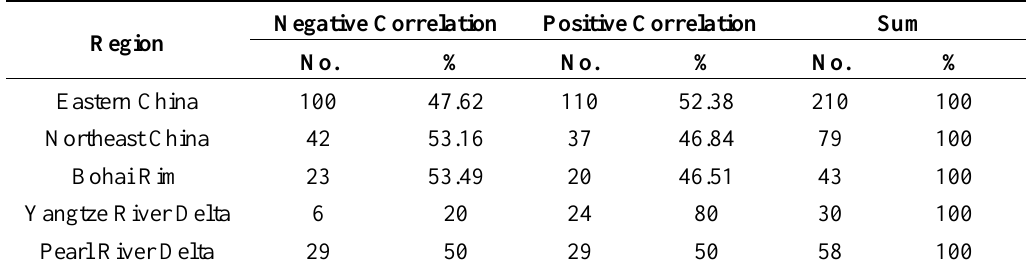
Figure 6. Spatial patterns of partial correlation coefficients between NDVI and precipitation of meteorological stations in Eastern China. Table 4. Partial correlation coefficients between NDVI and precipitation of meteorological stations in Eastern